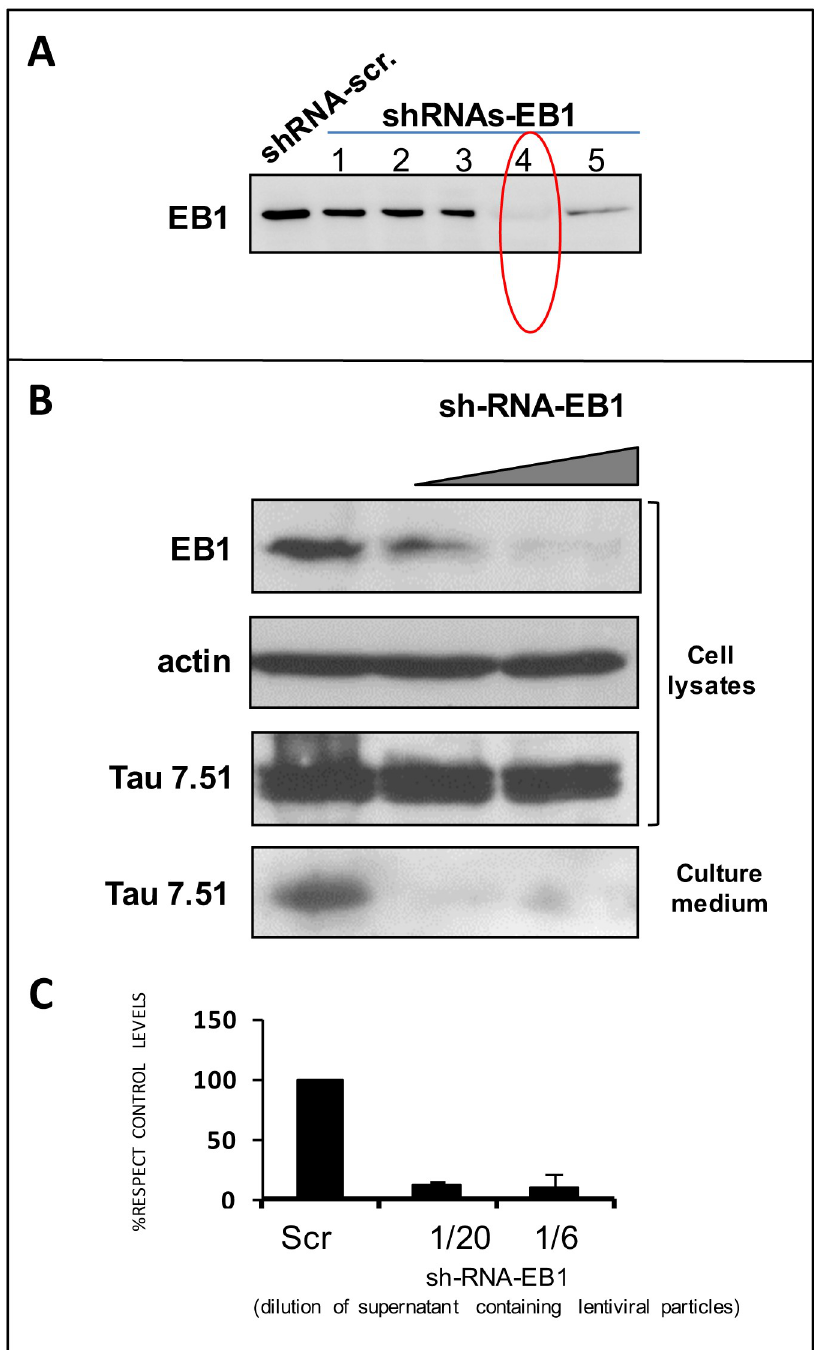
Fig 5. EB1 depletion decreases tau secretion. A) Different levels of EB1 downregulation upon transduction of five different specific shRNAs for human EB1 in HEK-293-tau3R cells. B) Increasing amounts of EB1-shRNA-4 lentiviral particles (dilution 1/20 and 1/6 of supernatant containing the lentiviral particles, see Methods section) were used to transduce HEK-293-tau3R cells, leading to a progressive decrease in endogenous EB1 levels (upper panel). This reduction of EB1 expression levels leads to a decrease amount of secreted tau in the culture medium (lower panel) without affecting the expression of intracellular tau. This reduction that not take place when scrambled shRNA (Src) was tested. C) Quantification of the data from